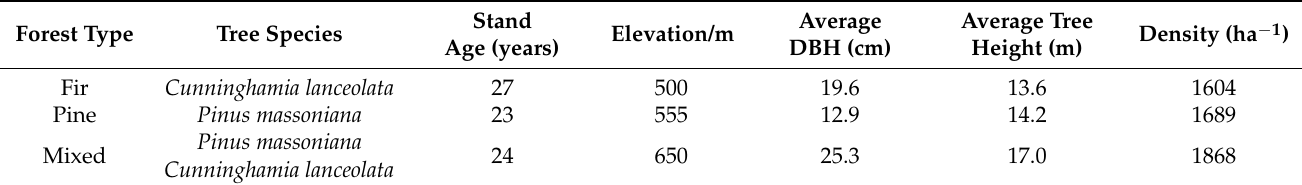
Table 1. Basic conditions of the experimental forest